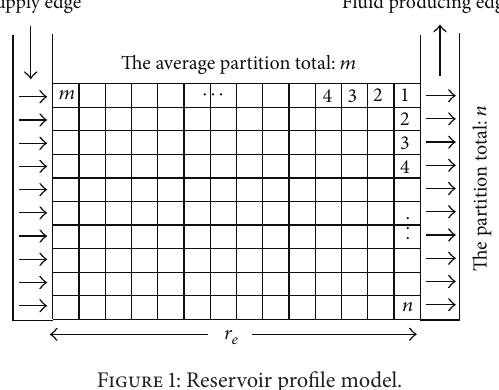
Figure 1: Reservoir profile